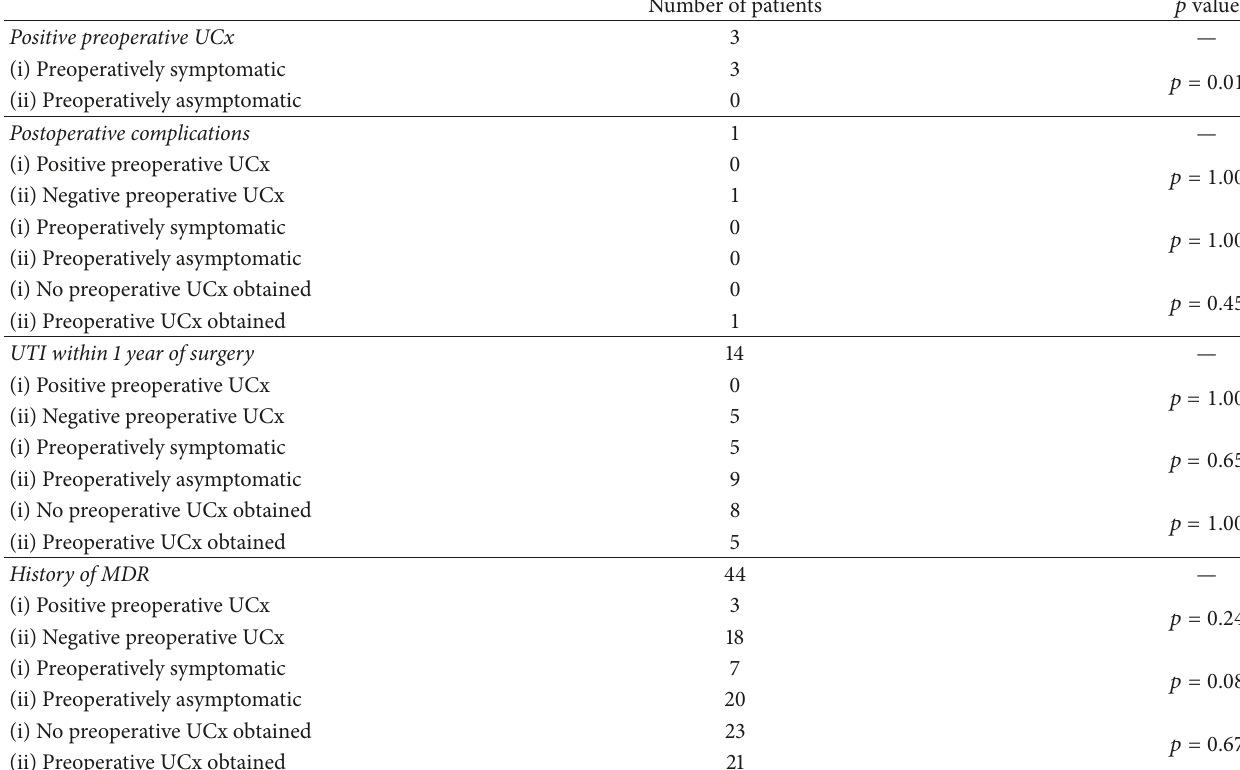
Table 2: Association testing between patient groups and outcomes or